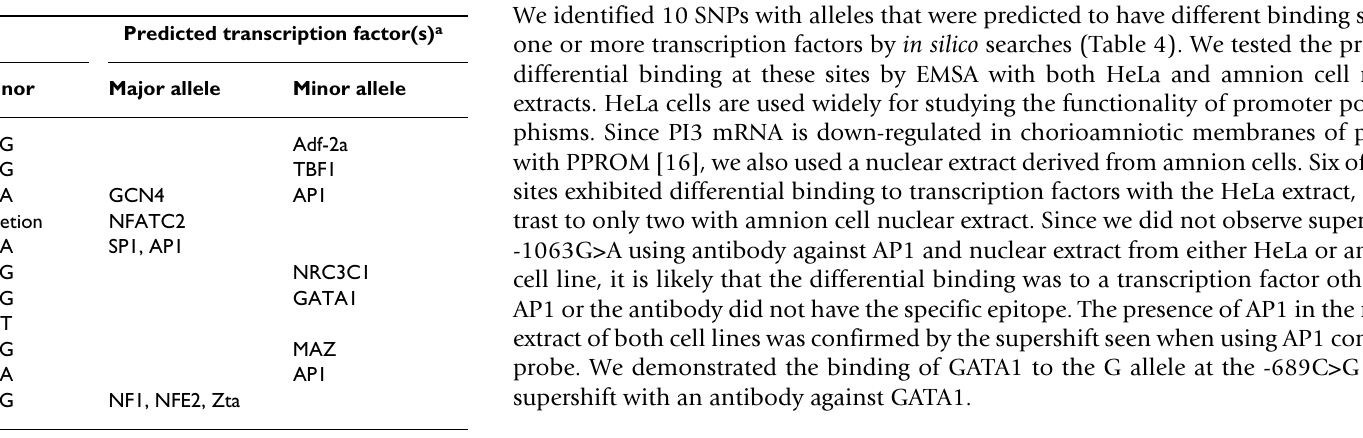
Table 4: Results from in silico searches for putative transcription factor binding